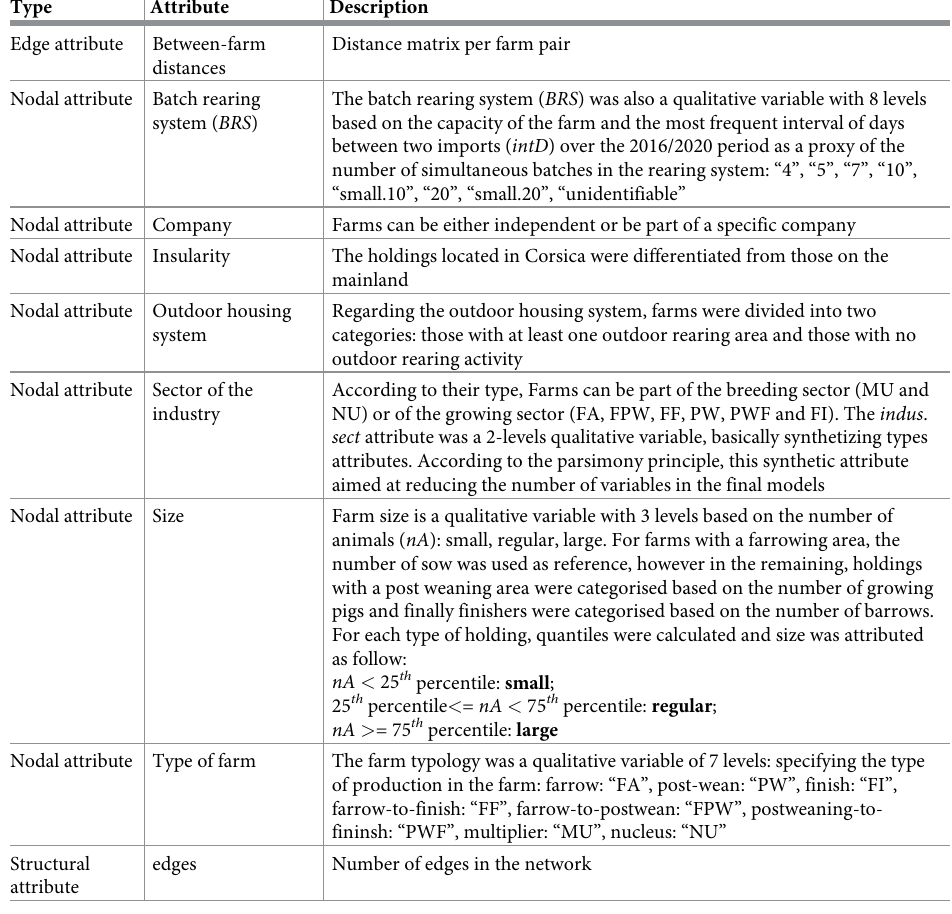
Table 5. Description of network